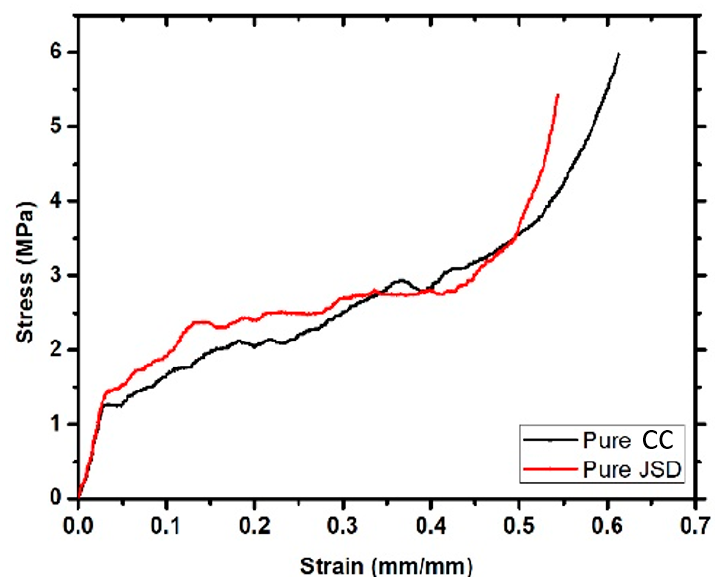
Figure 10. Stress strain graph for both Pure CC and pure JSD.